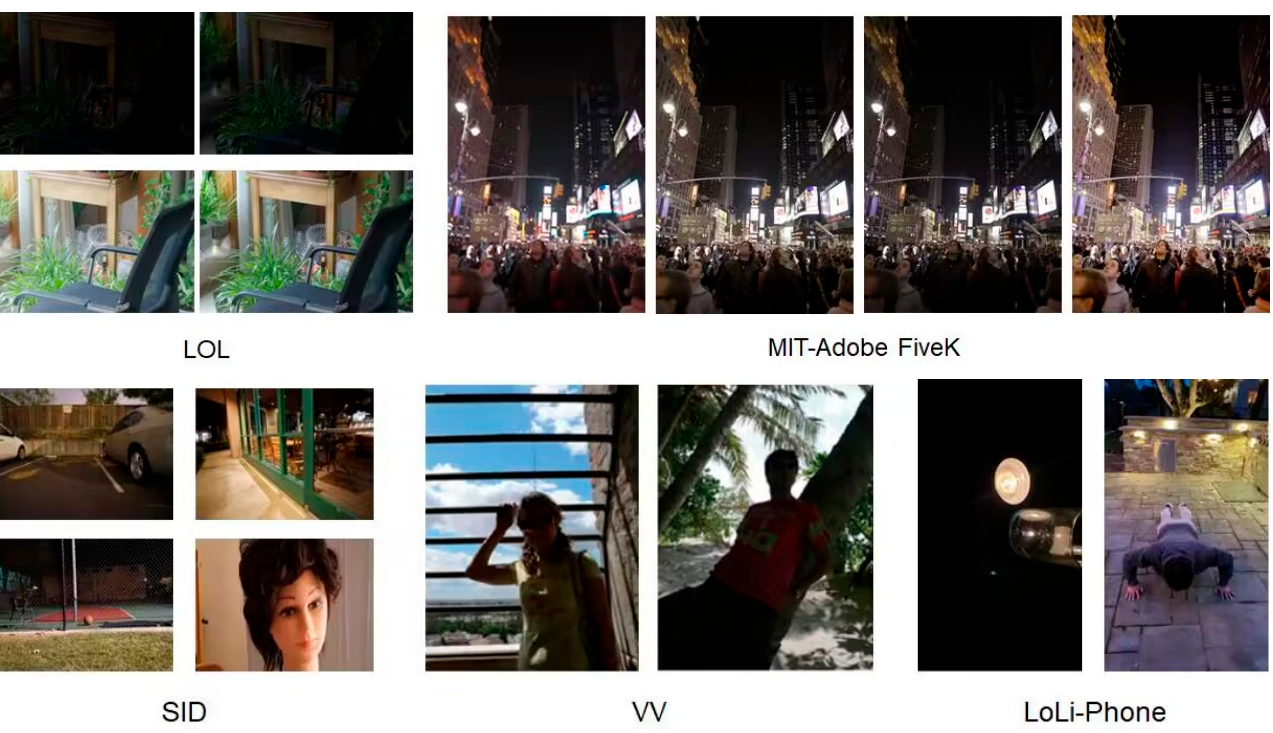
Figure 6. Examples of low-light image datasets. Note that the first line is paired, while the second line is unpaired. The full names of some abbreviations are as follows: LOL (Low-light Dataset), SID (See in the dark), VV (Vasileios Vonikakis). Table 2. Summary of low-illumination image datasets.